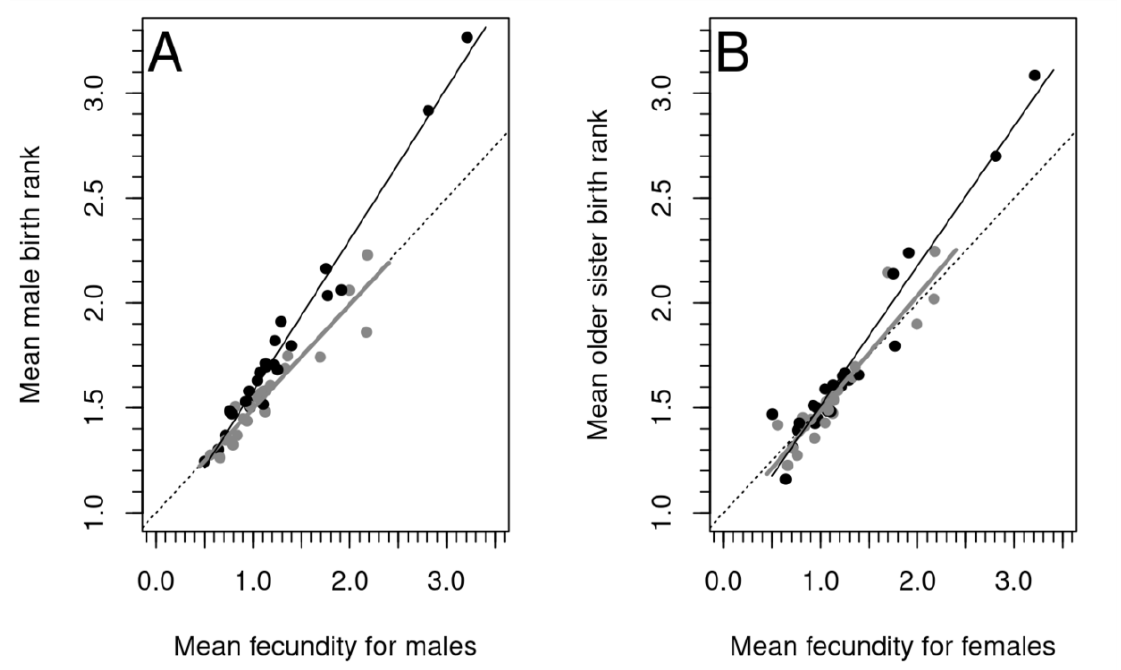
Figure 2 . Mean birth rank in relation to fecundity. A. Birth rank among males. B. Birth rank among older sisters. The mean fecundity for only males or only females is computed as half the overall fecundity. Each sample is represented as a dark dot for homosexuals, and as a grey dot for heterosexuals. The solid lines are regression lines for homosexual samples (black), and heterosexual samples (grey). The dotted line represents the theoretical expectation between mean birth rank and mean fecundity (i.e. Equation